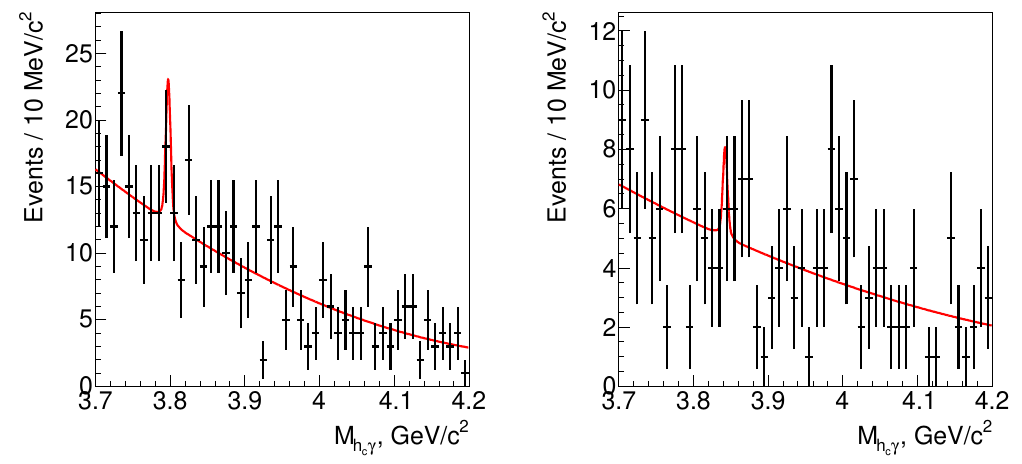
Figure 6 . Fit results for the channels B 0